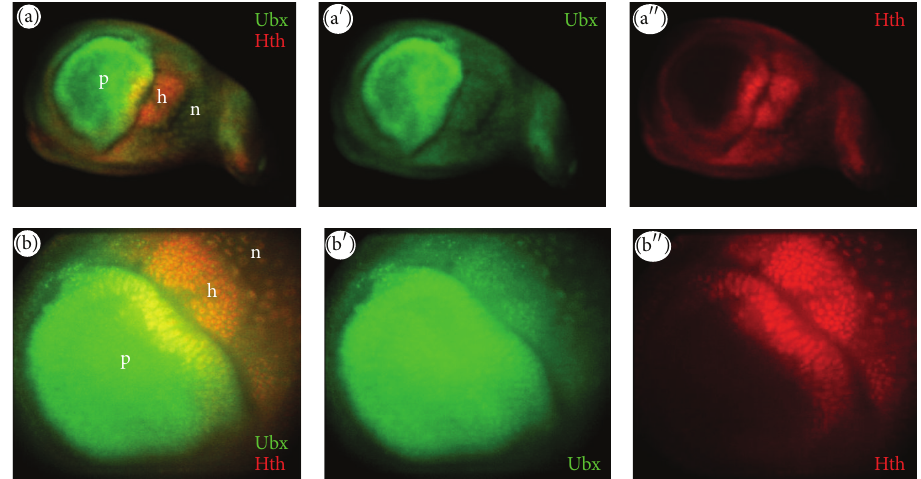
Figure 9: Double-labelling of Ubx and Hth in haltere discs. ((a)–(a 󸀠󸀠 )) Ubx and Hth are colocalised in hinge (h) and notum (n) regions but show different expression levels ((b)–(b 󸀠󸀠 )) of Ubx and Hth in a specific region of the dorsal hinge (h); p = pouch; n = notum; h = hinge.